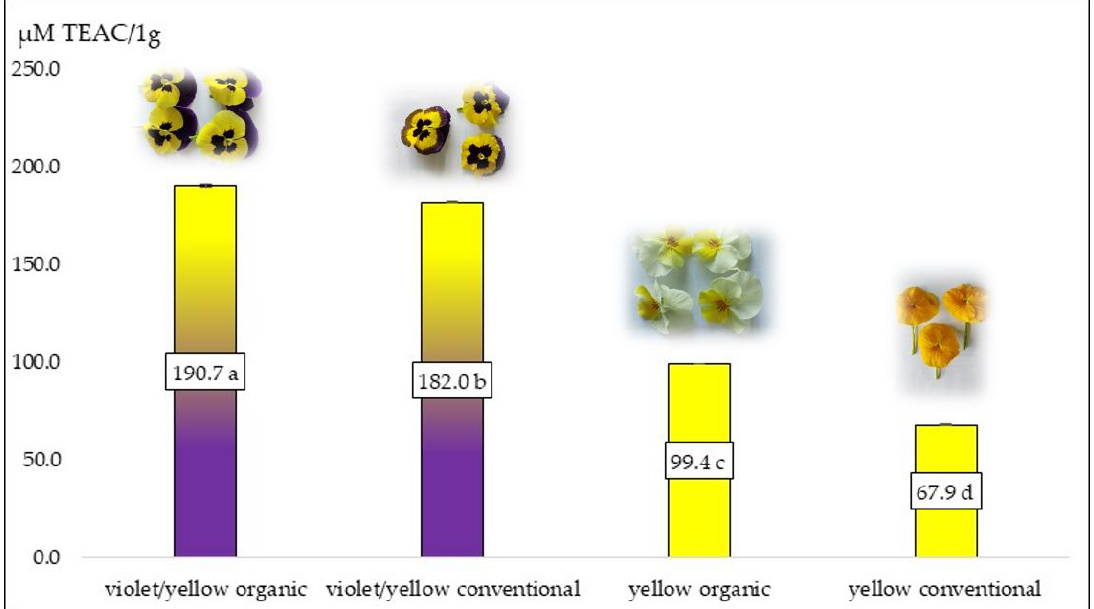
Figure 1. Antioxidant activity of different pansy flowers. Means on bars followed by the same letter are not significantly different at the 5% level of probability ( p < 0.05). Table 3. Pearson’s coefficient (R 2 ) between antioxidant activity and total polyphenols, anthocyanins, and carotenoids in organic and conventional pansy flowers with different colors.